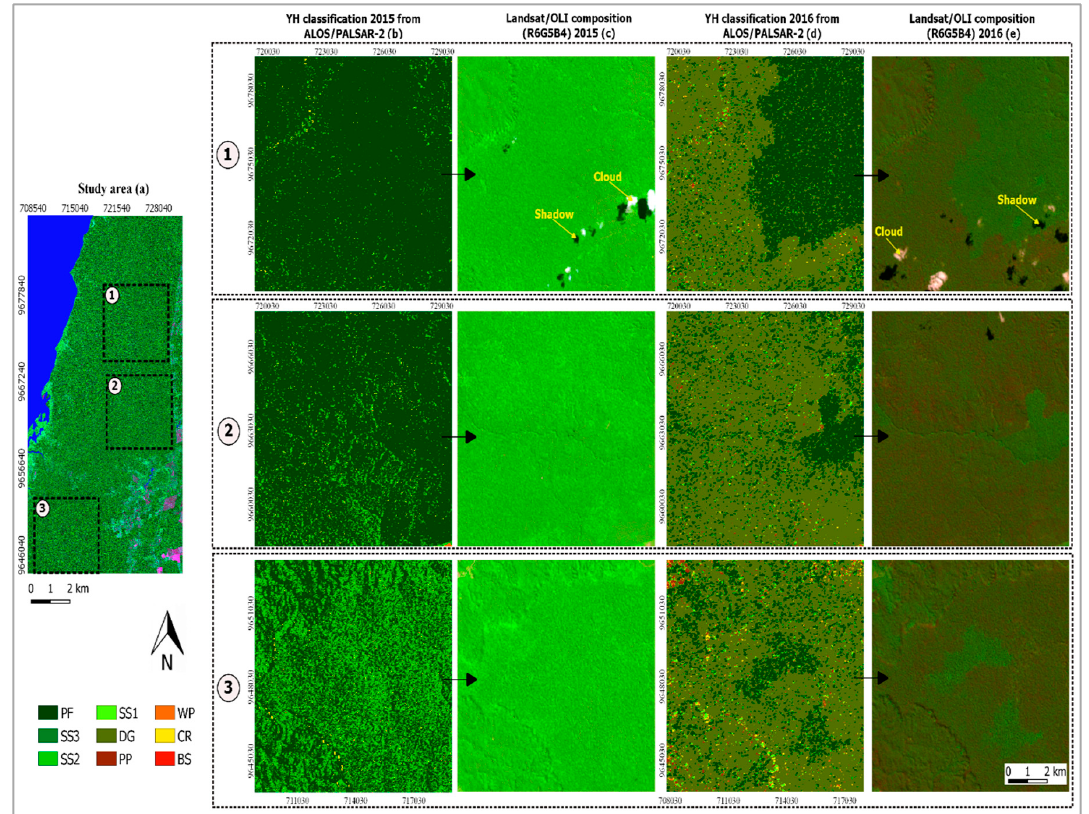
Figure 12. Location of the study area in the Tapajós National Forest. The images correspond to RGB color composite of HH/HV, VV/VH, and HH/VV ratios of ALOS/PALSAR-2 images mosaic ( a ). Black rectangles represent land cover and forest degradation by fire (subsets 1 , 2 , and 3 ) of the study area: the classification based on Yamaguchi (YH) attributes from 2015, derived from the ALOS/PALSAR-2 polarimetric images ( b ); its corresponding area imaged by Landsat-8/OLI satellite obtained on August 14, 2015 and shown by the R6G5B4 composition, corresponding to the period before fire events ( c ); the YH classification from 2016, derived from ALOS/PALSAR-2 ( d ); and its corresponding area imaged from Landsat-8/OLI satellite obtained June 29, 2016 and shown by the R6G5B4 composition, corresponding to the period after the fire ( e ). For LULC class identification, see Table 1.